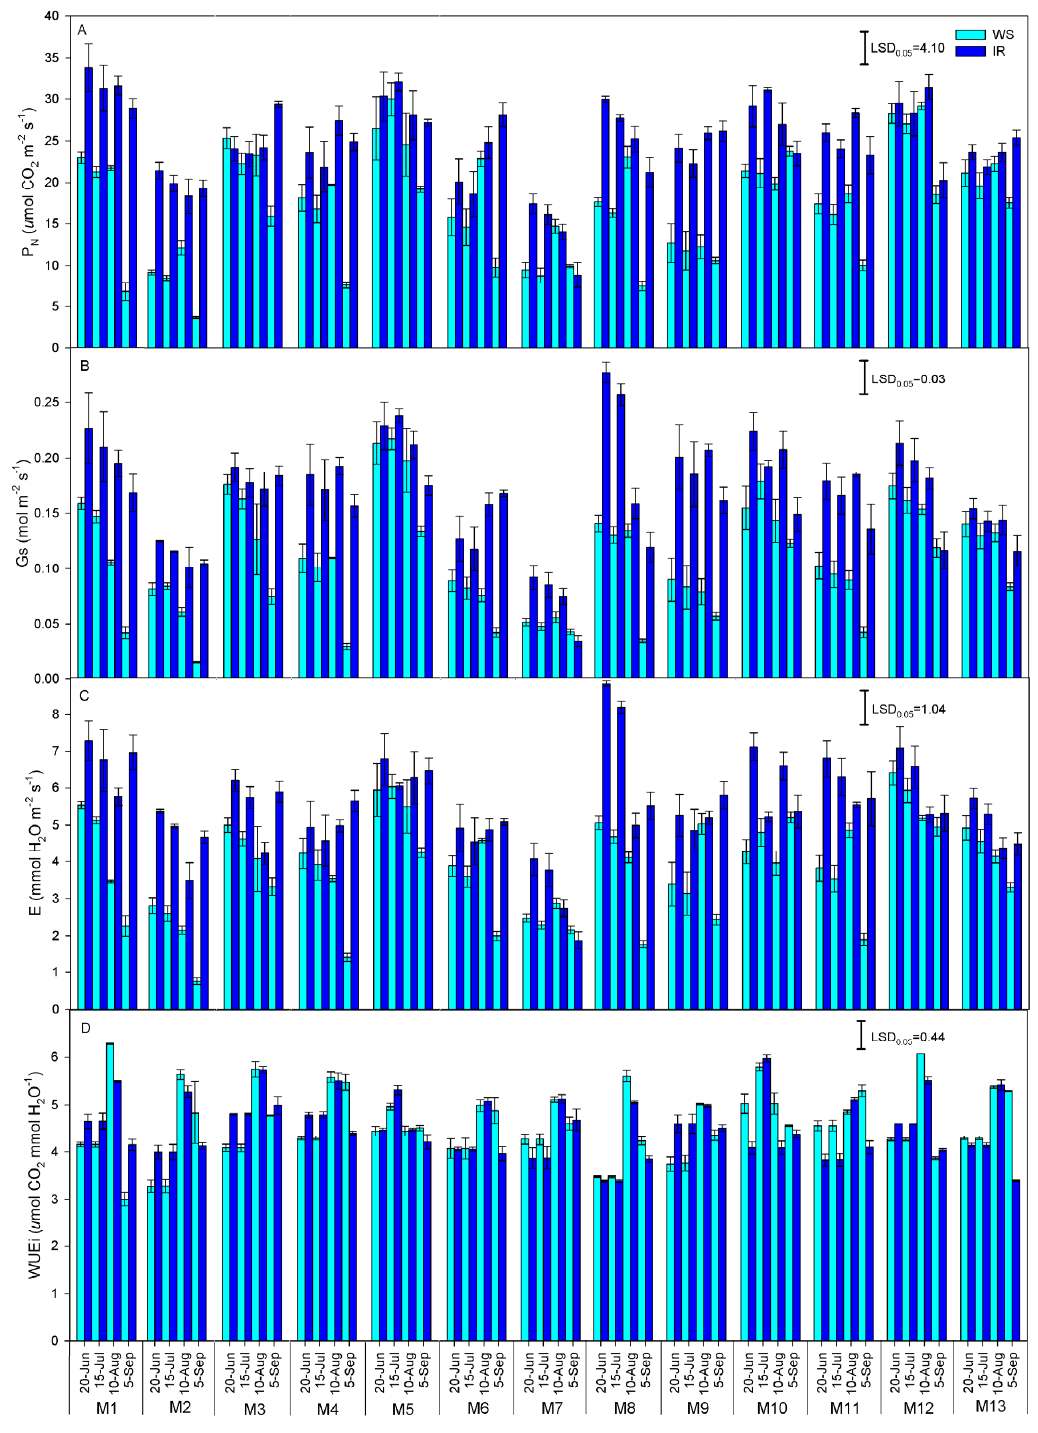
Figure 3. ( A ) Net photosynthesis (P N , μ mol CO 2 m − 2 s − 1 ); ( B ) Stomatal conductance (Gs, mol m − 2 s − 1 ); ( C ) Transpiration rate (E, mmol H 2 O m − 2 s − 1 ); ( D ) Instantaneous water use efficiency (iWUE, μ mol CO 2 mmol H 2 O − 1 ) of Miscanthus genotypes (M1— Mxg , M2— M. sacchariflorus , M3–M6— M. floridulus , M7–M13— M. sinensis ) under rainfed (WS) and irrigated (IR) conditions. LSD 0.05 indicates a significant “genotype × irrigation × date of measurement” interaction at p ≤ 0.05 .